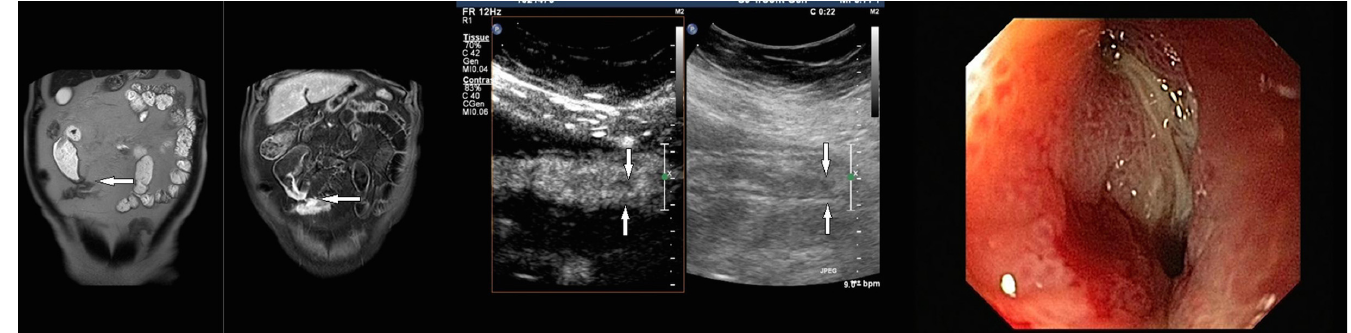
Fig 2. Forty- two-year-old male patient with Crohn ’ s disease and enteroenteral fistula of the terminal ileum. A: Coronal MR Enterography images (T2-weighted single-shot turbo spin-echo, on the left image; T1-weighted fat saturated, spectrally attenuated inversion recovery after Gadoteric acid administration, on the right image) of a patient with enteroenteral fistula and increased enhancement after contrast administration (white arrow). B: Longitudinal Contrast enhanced ultrasound of the affected ileum of the same patient (Gray scale ultrasound image on the right side; Contrast enhanced ultrasound image on the left side), showing severe wall thickening on the Gray scale ultrasound (white arrow) and strong enhancement after Sonovue administration on the Contrast enhanced ultrasound (white arrow), but no fistula. C: Endoscopic image of the same patient, with a fistula opening in the terminal